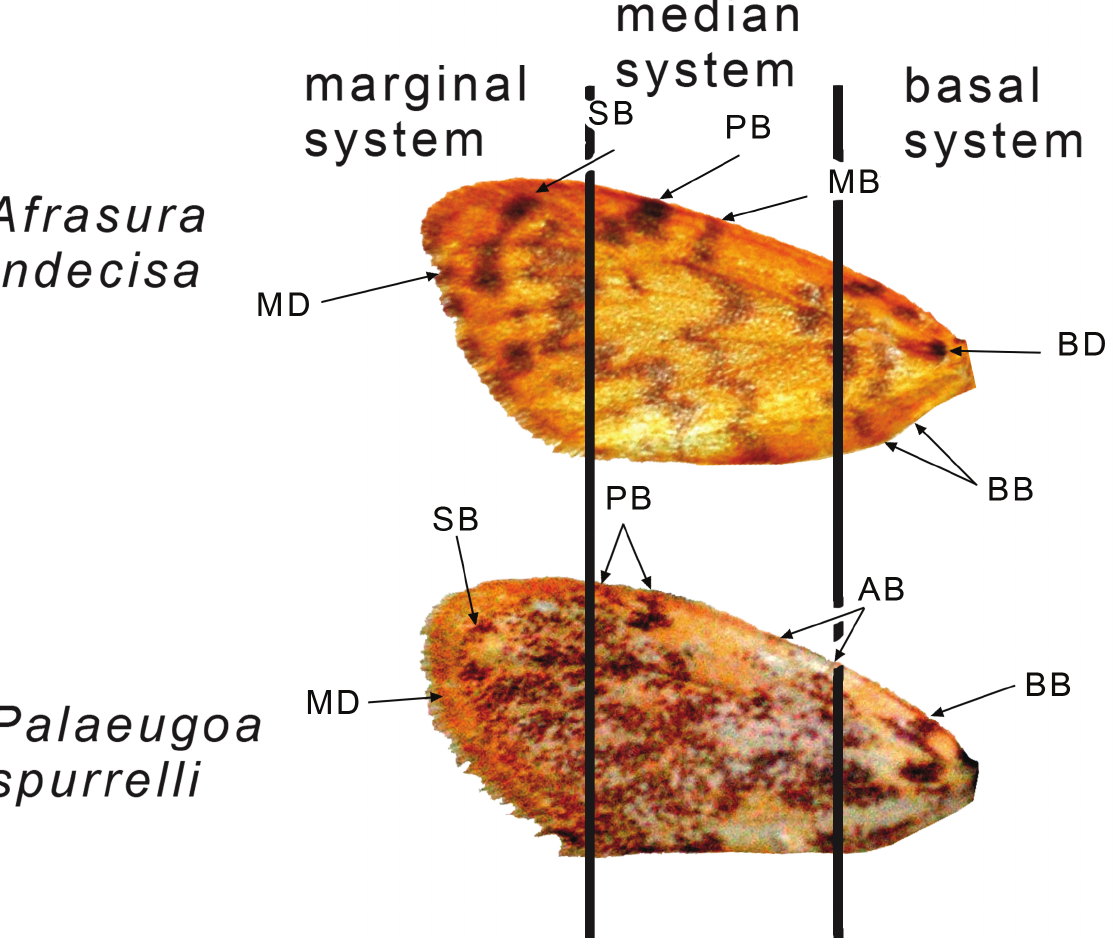
Fig. 5. Forewing of Afrasura indecisa (top) and Palaeugoa spurrelli (bottom) and their related pattern symmetry systems. AB, antemedian bands; BB, basal band(s); BD, basal dot; MB, median band; MD, marginal dots; PB, postmedian band(s); SB, submarginal